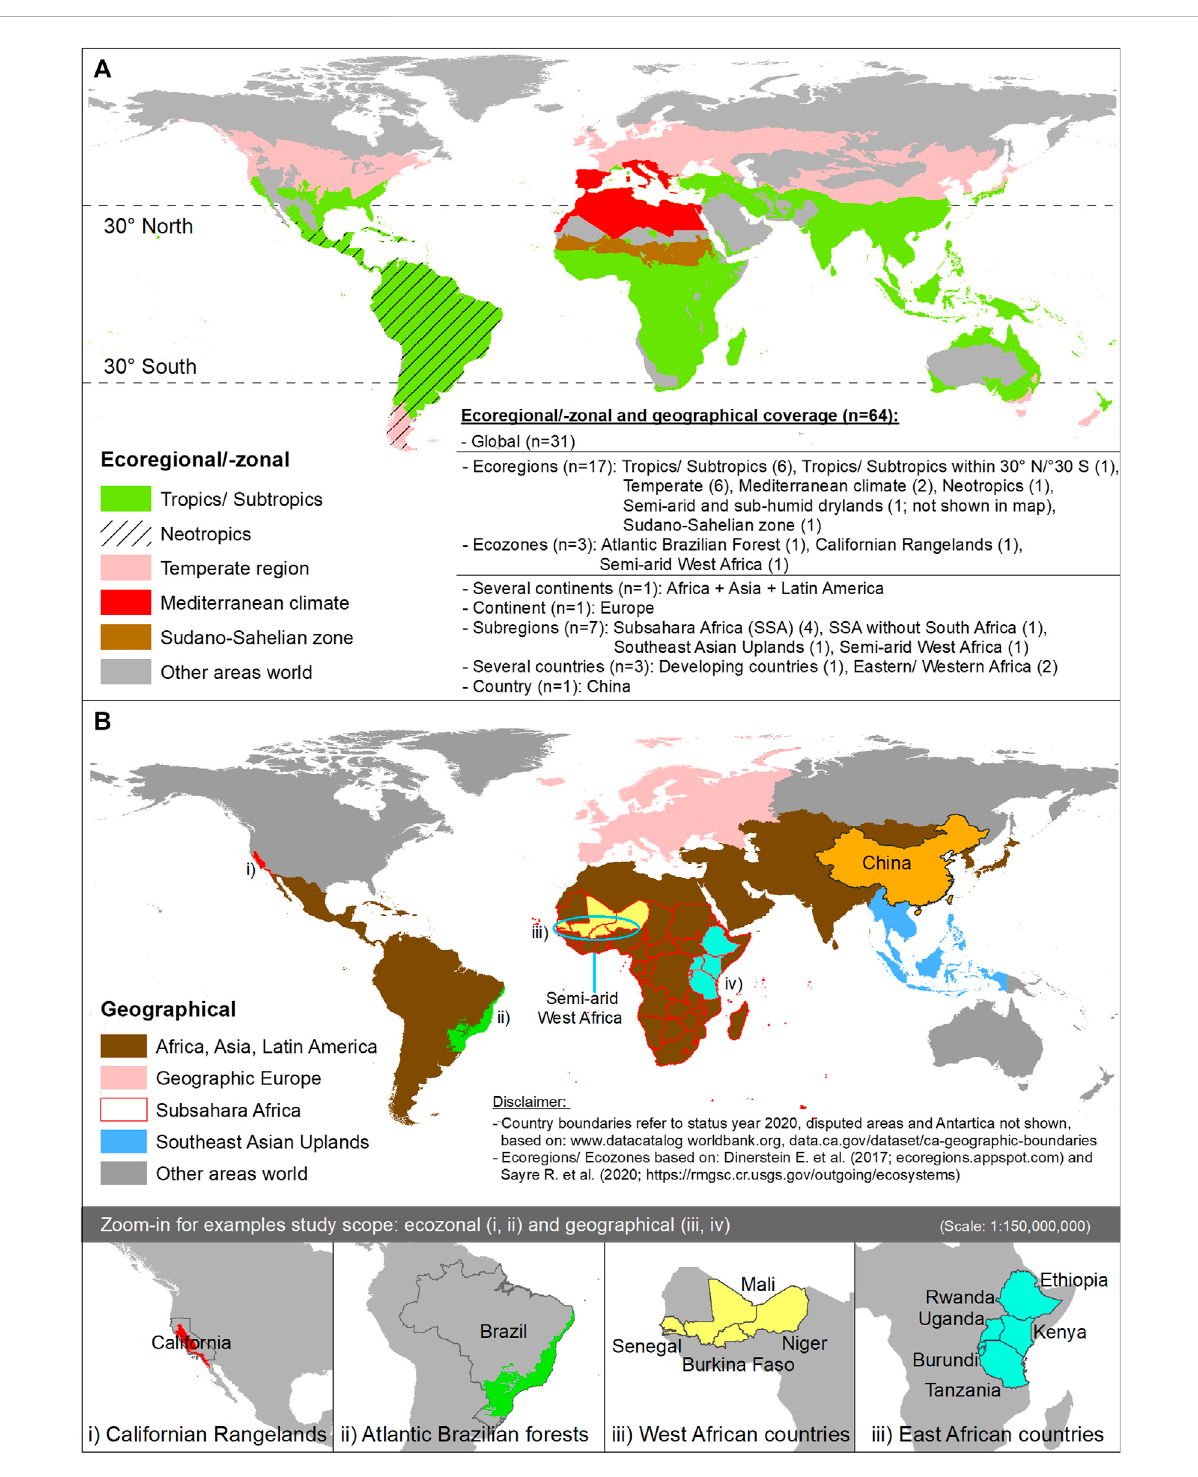
FIGURE 3 Spatial coverage applied by systematic reviews of agroforestry outcomes (n = 64 articles). The classi fi cation is displayed as de fi ned by the studies ’ authors. Map (A) shows the ecoregional and ecozonal classi fi cation applied by 20 review articles and map (B) the geographical classi fi cation applied by 13 review articles (classi fi cation based on Dinerstein et al., 2017; Sayre et al., 2020). 31 articles are referred to global as they did not apply any spatial